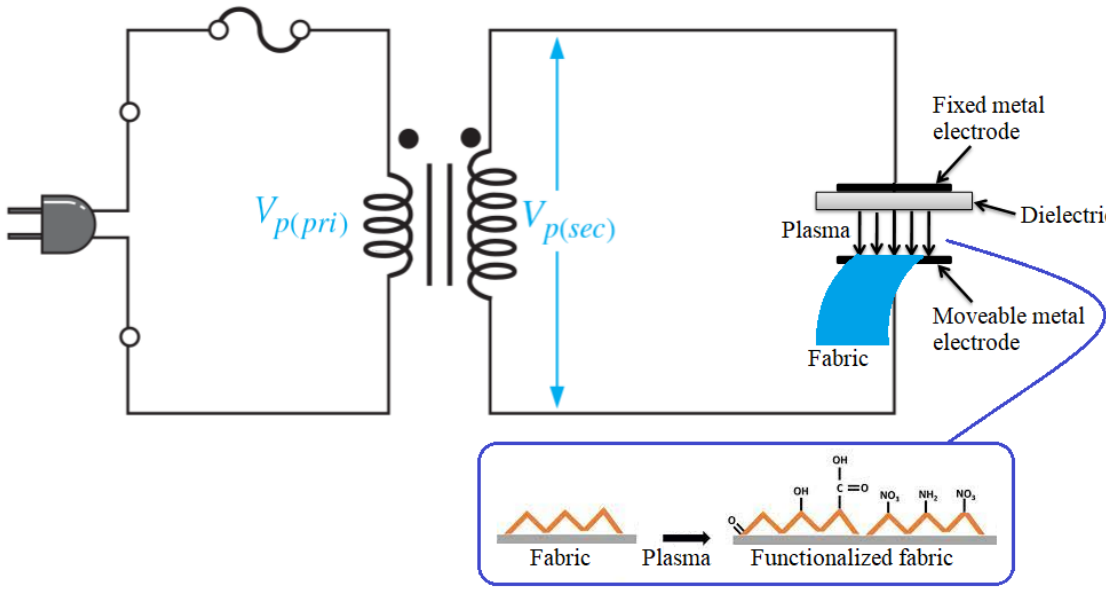
Figure 1. Illustration of DBD plasma system for activation of cotton fabric in open air.